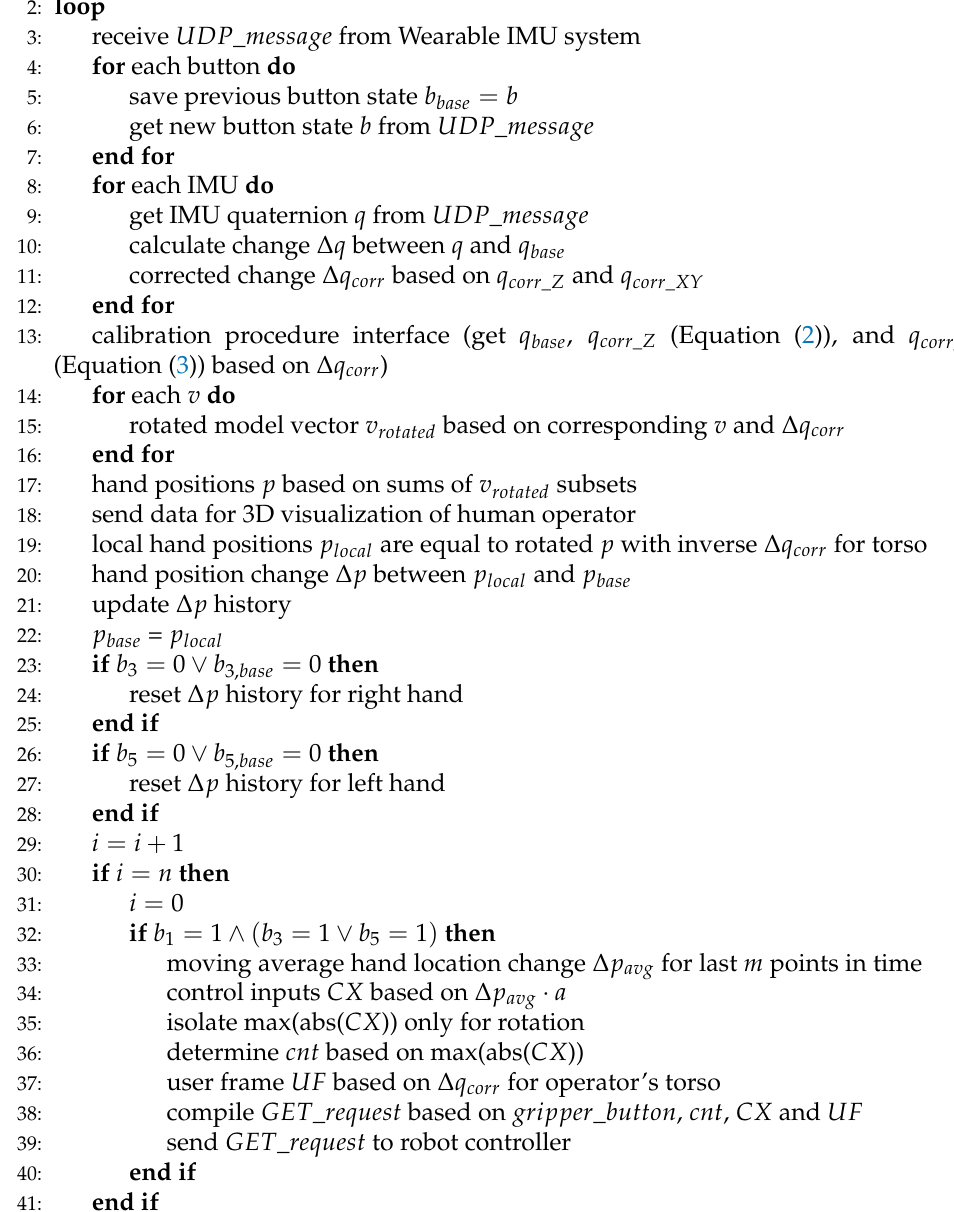
Algorithm 2 Control computer: Transformation of rotations to